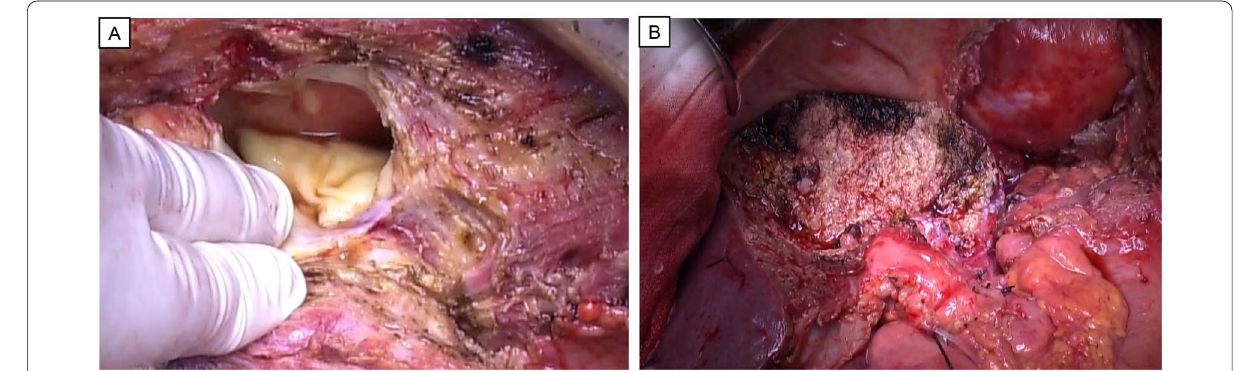
Fig. 3 A The pericardium was opened, and a white cystic structure was observed. B Expanded left-sided hemi-hepatectomy, IVC